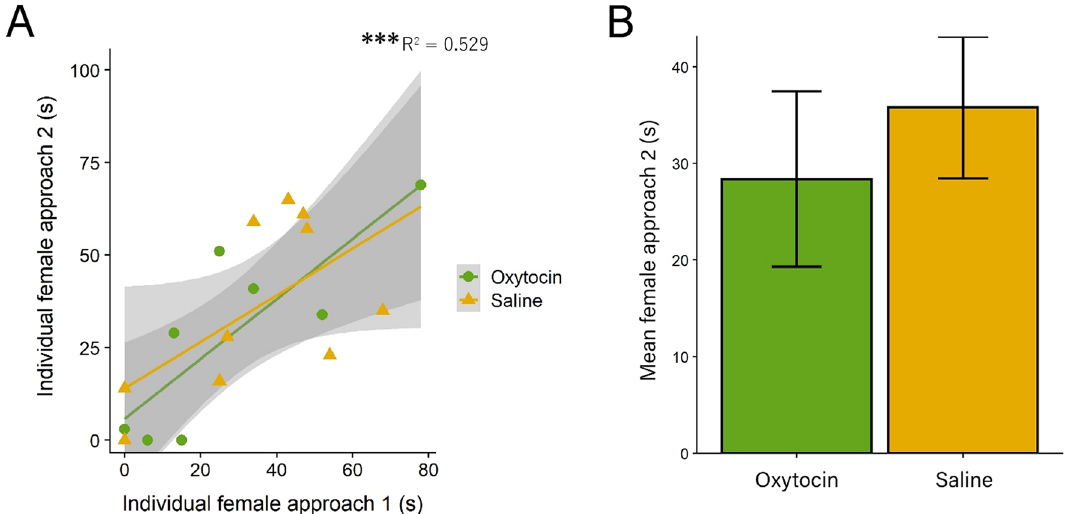
Figure 5. A separate cohort of unpaired females showed high test–retest reliability. ( A ) Unpaired females showed reliable response to the playback approach test 13–17 later. ( B ) IN-OT did not significantly change female approach at the second test. (*** = p < 0.001). Error bars are ±